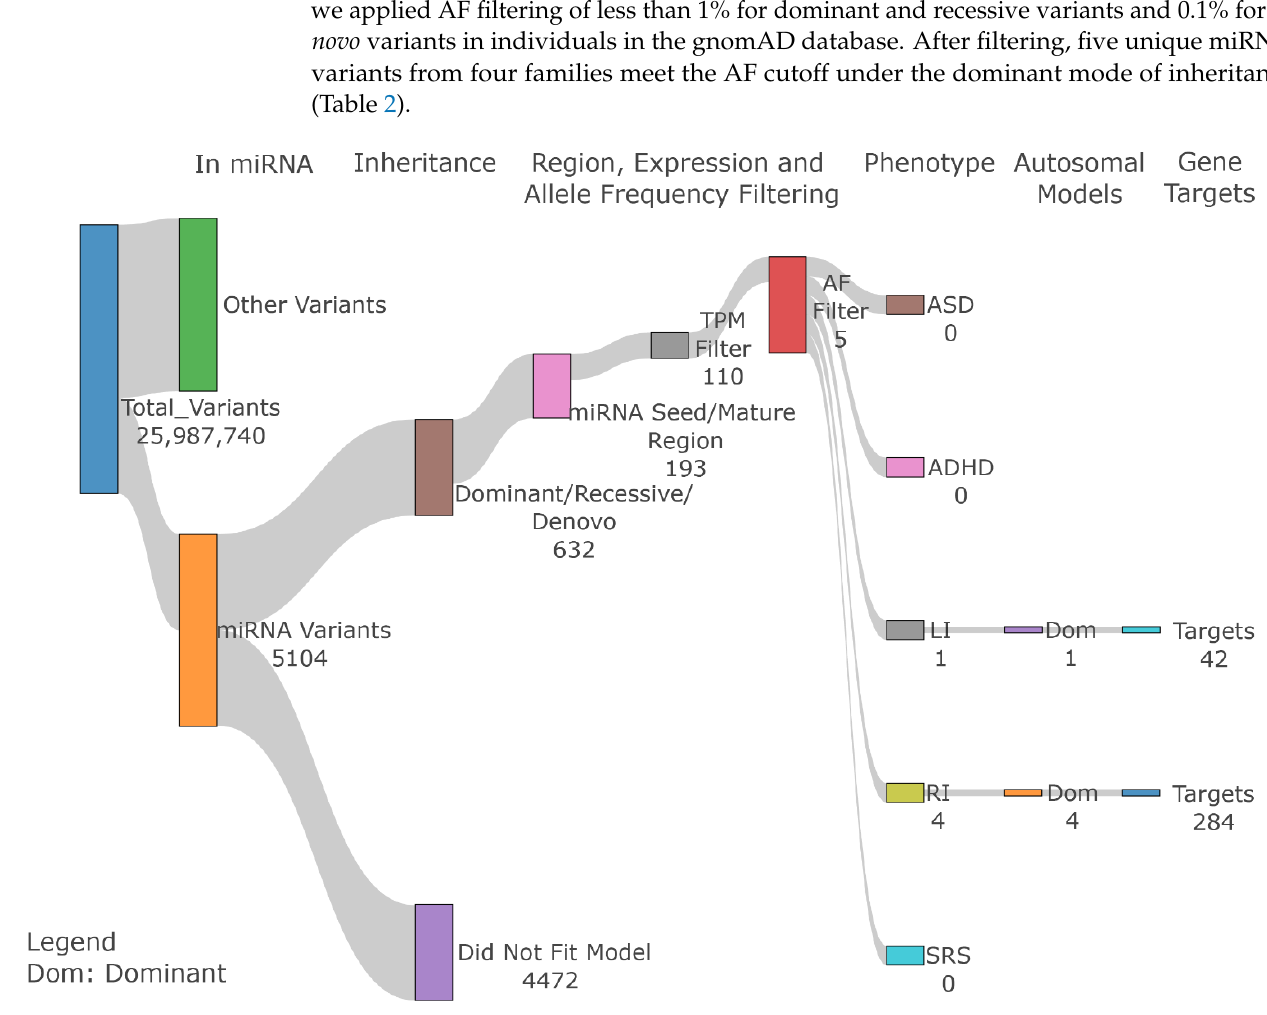
Figure 1. miRNA variant filtering steps. After selecting all variants within miRNAs, we filtered variants based on their inheritance pattern, miRNA region annotation, brain expression pattern, and population allele frequency to select final candidate variants.